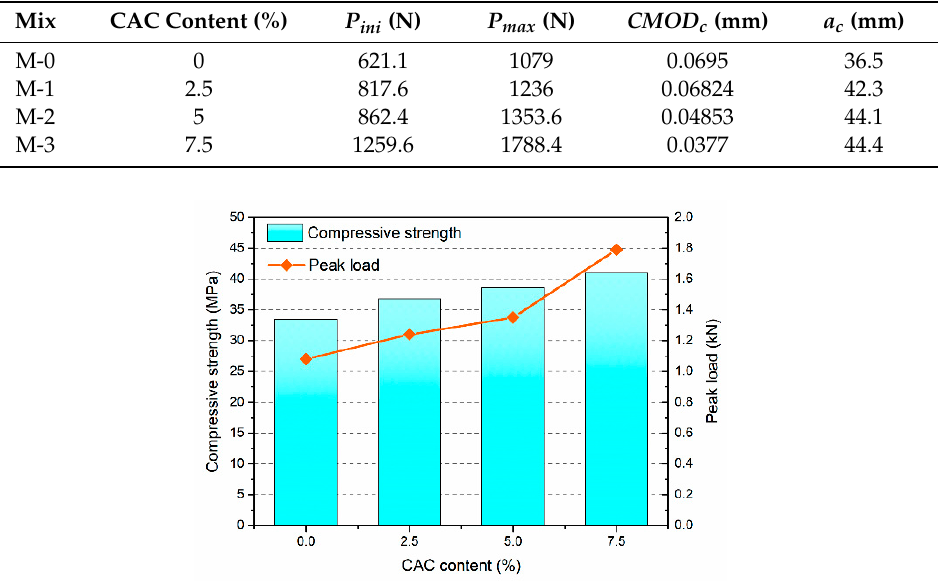
Table 5. Experimental results of fracture parameters.